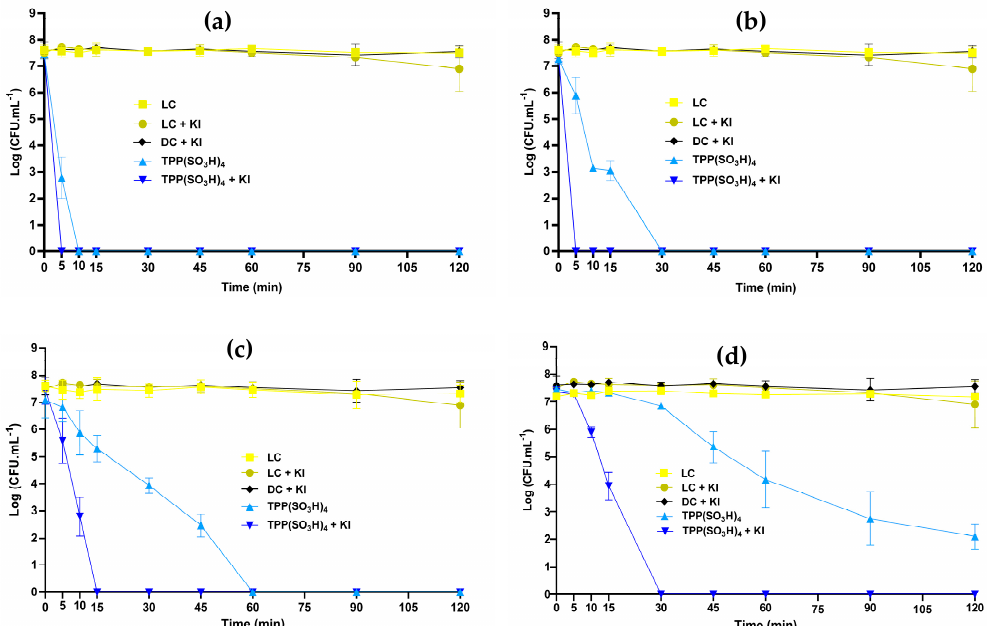
Figure 4. Photodynamic inactivation of MRSA in the presence of TPP(SO 3 H) 4 at 5.0 µ M ( a ), 1.0 µ M ( b ), 0.5 µ M ( c ), and 0.1 µ M ( d ) alone or in combination with KI at 100 mM, along 120 min of irradiation (white light at an irradiance of 25 mW cm − 2 ). Each value represents the mean ± standard deviation of three independent assays, with three replicates each.